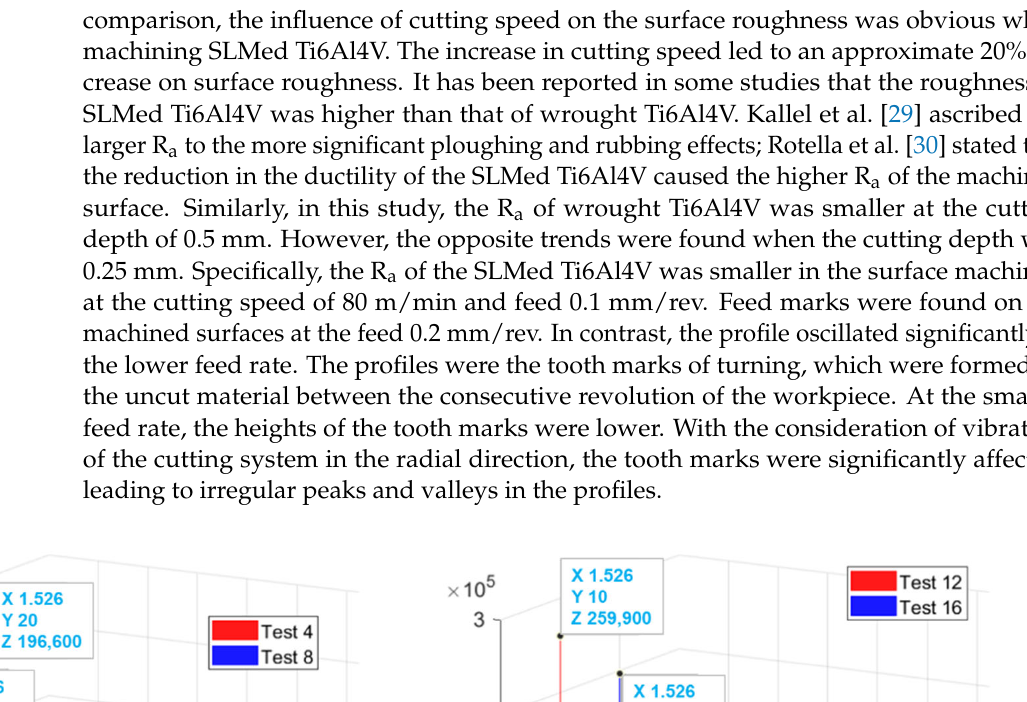
Figure 11. FFT of the signal of radial force when machining wrought and SLMed Ti6Al4V materials at the speed of 120 m/min and feed of 0.1 mm/rev: ( a ) at the cutting depth of 0.25 mm, ( b ) at the cutting depth of 0.5 mm.